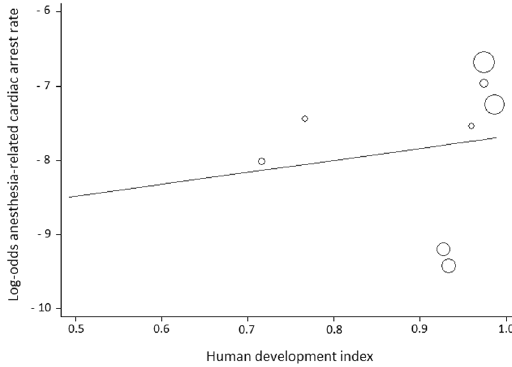
Figure 5. Meta-regression analysis of anesthesia-related cardiac arrest rates according to Human Development Index (HDI) status. Each circle represents a study and indicates its weight in the analysis. The correlation between anesthesia-related cardiac arrests and HDI was not significant (slope: 1.6188; 95% CI: − 8.6021 to 11.8399; P =